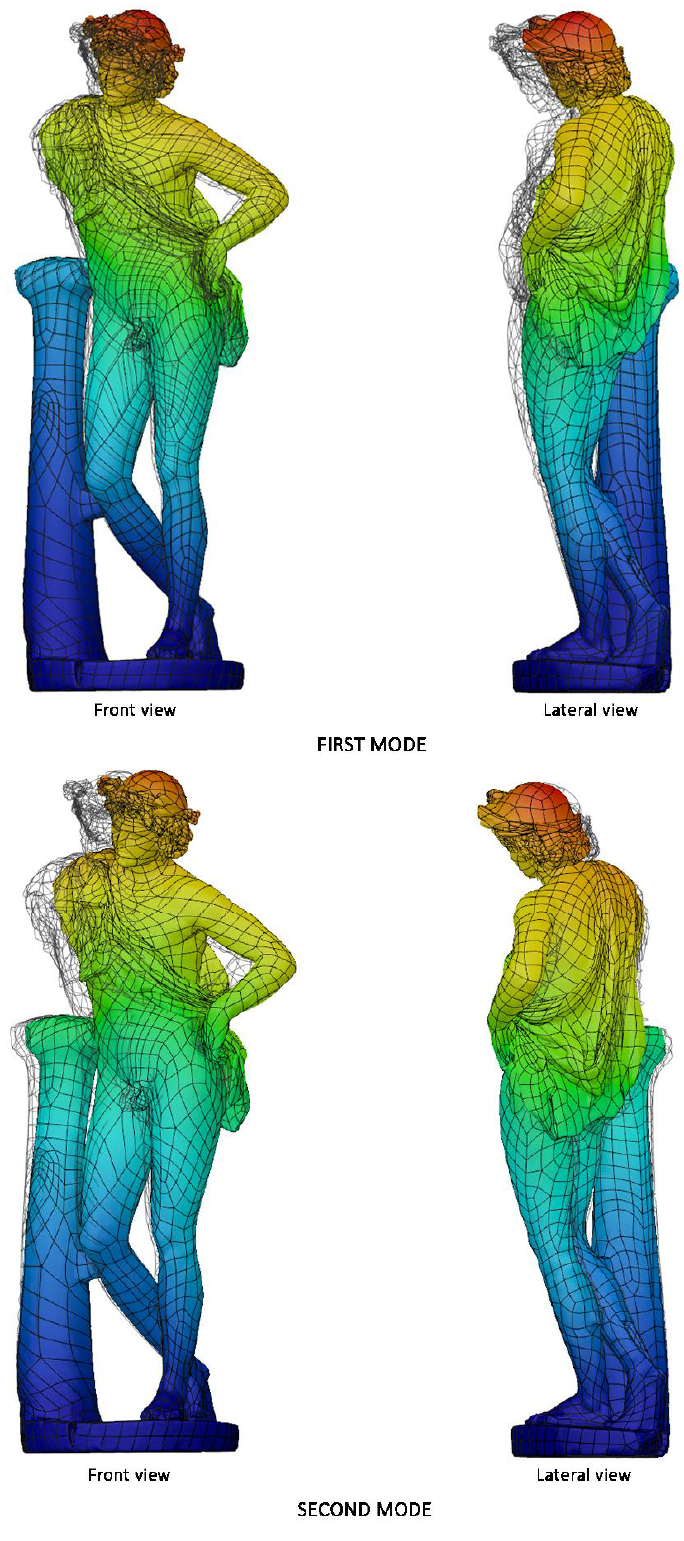
Figure 20. Modal analysis of Resting Satyr : first (top— f 1 = 20.7 Hz) and second (bottom— f 2 = 46.5 Hz) mode; displacement mapping color code ranges between blue (still points) to red (maximum modal displacements).